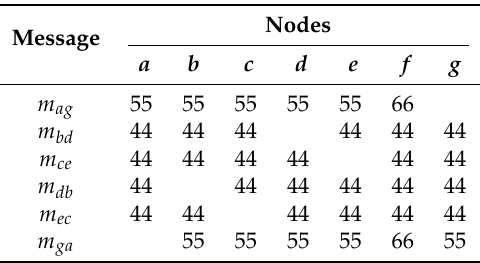
Table 5. Worst case response time per node.